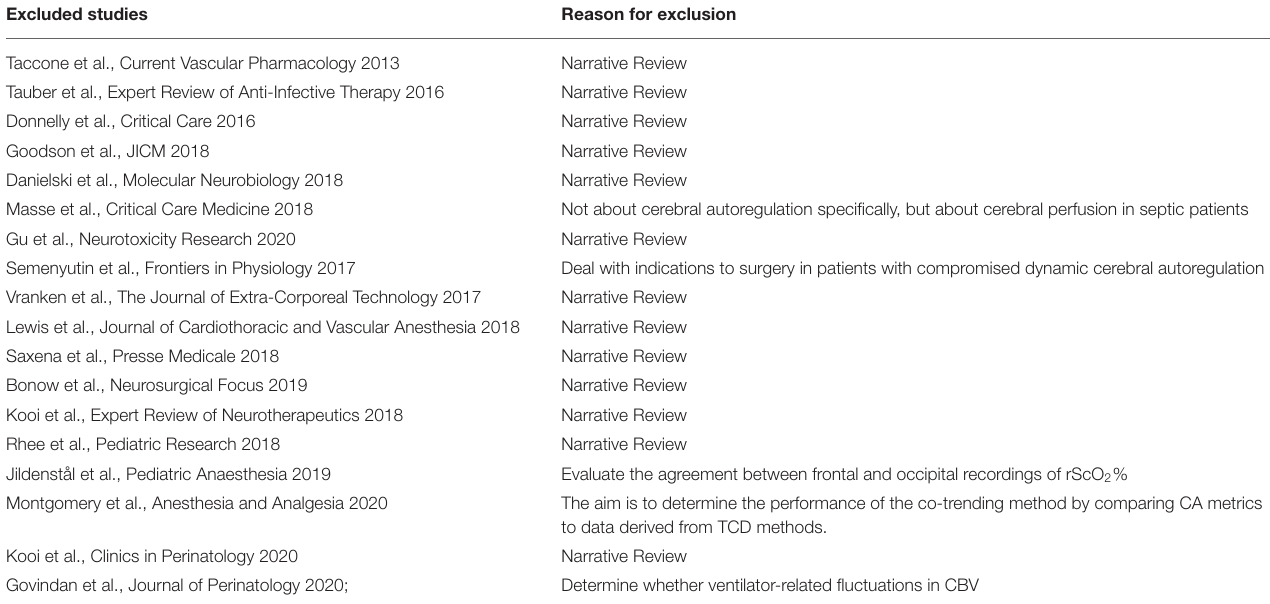
TABLE 3 | Summary of excluded studies and reasons for